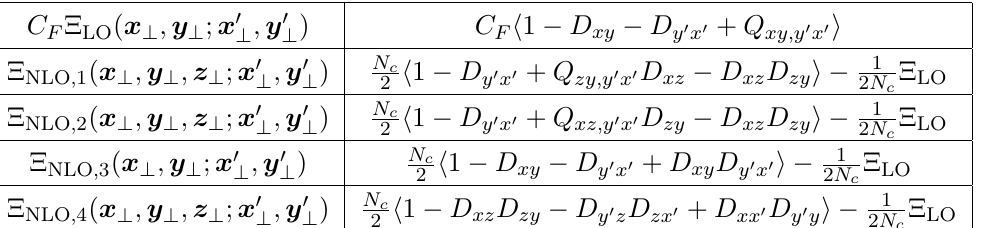
Table 2 . Color correlators contributing to the next-to-leading order cross-section. Only Ξ NLO , 1 and Ξ NLO , 2 are not invariant under complex conjugation and the x ⊥ → x 0